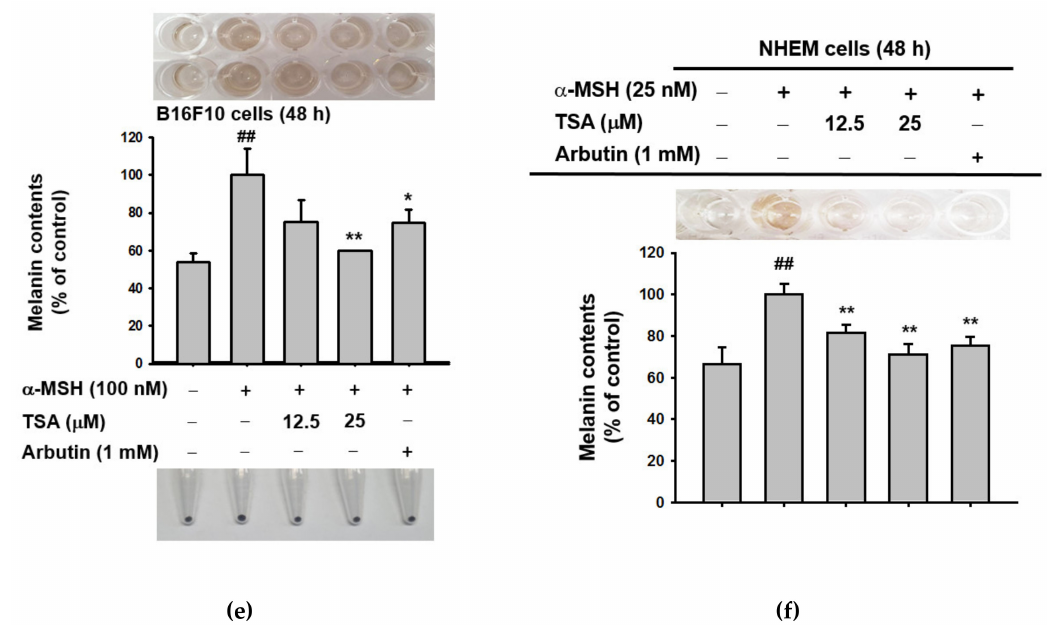
Figure 2. The antimelanogenesis effect of TSA in murine melanoma cells (B16F10). ( a , b ) B16F10 cells and NHEMs were treated with TSA (6.25–200 µ M) for 48 h, and cell viability was analyzed using MTT assay ( n = 5 from 3 independent experiments). ( c ) Mushroom tyrosinase was reacted with TSA (6.25–25 µ M) or kojic acid (300 µ M), and L-DOPA was added. Tyrosinase activity was analyzed by measuring absorbance at 475 nm ( n = 4 from 3 replicates). ( d – f ) B16F10 cells and MHEMs were treated with TSA (12.5–25 µ M) or arbutin (1 mM) for 48 h. Cell-cultured media were collected for melanin secretions by measuring absorbance at 470 nm ( n = 4 from 3 independent experiments). The intracellular melanin contents were determined by measuring optical density at 450 nm with 3 replications. +: indicates treatment, − : indicates non-treatment. For all applicable experiments, statistical significance was evaluated using the Mann–Whitney U test. ## p < 0.01 compared with the normal group, * p < 0.05 compared with the control group, ** p < 0.01 compared with the control